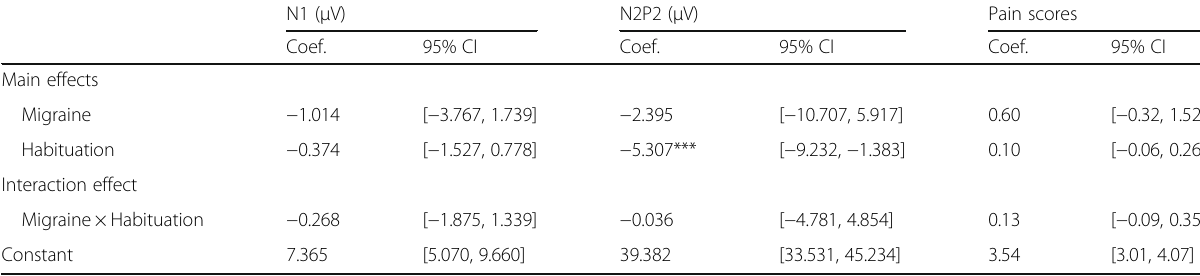
Table 5 Estimated magnitudes and habituation in migraineurs in the interictal phase and